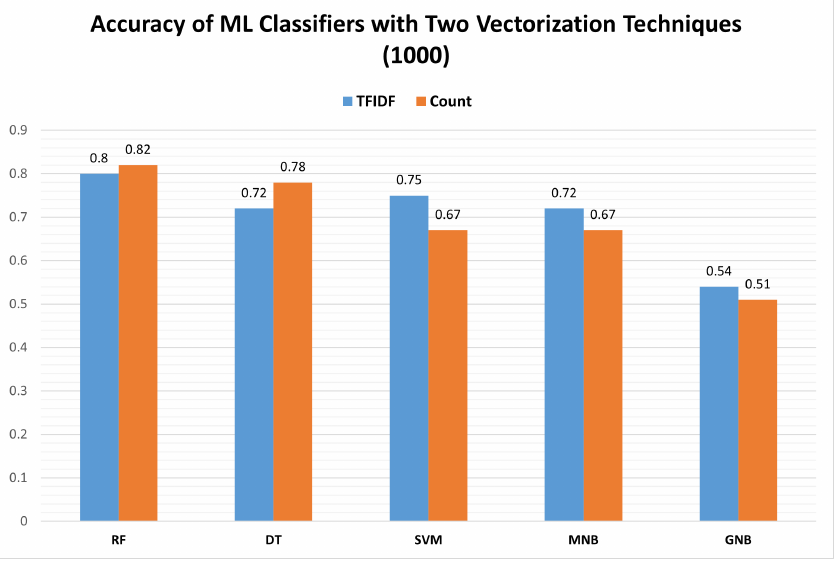
Figure 6. Accuracy of the small data set (1000